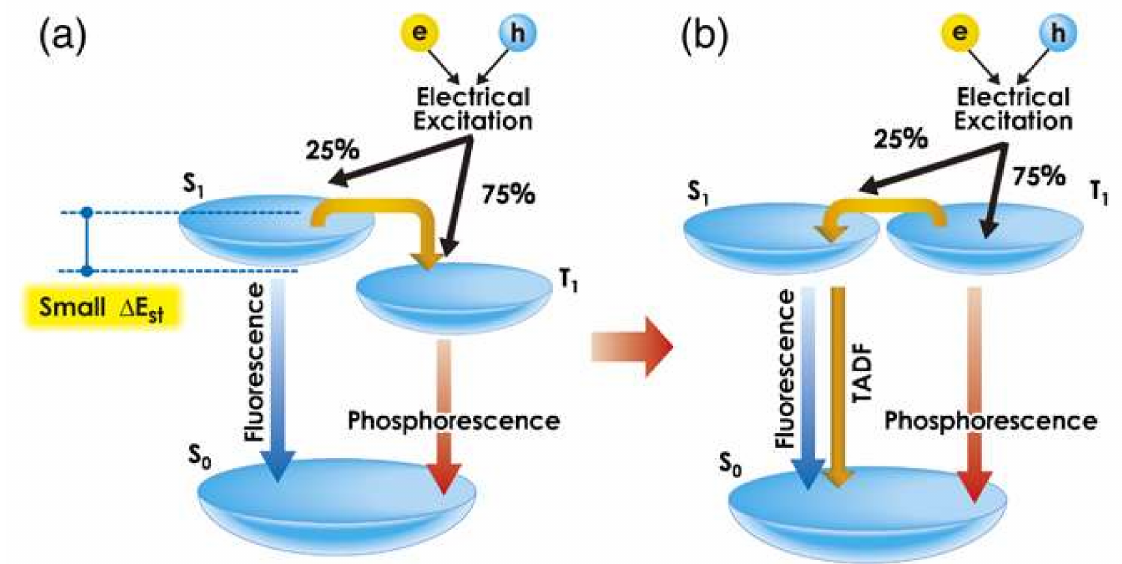
Figure 1. Light generation processes in ( a ) fluorescence and phosphorescence-based organic light-emitting diodes (OLEDs) and ( b ) thermally activated delayed fluorescence (TADF)-based OLEDs. Figure reproduced with permission from Adachi et al. [54] (reproduced with permission from